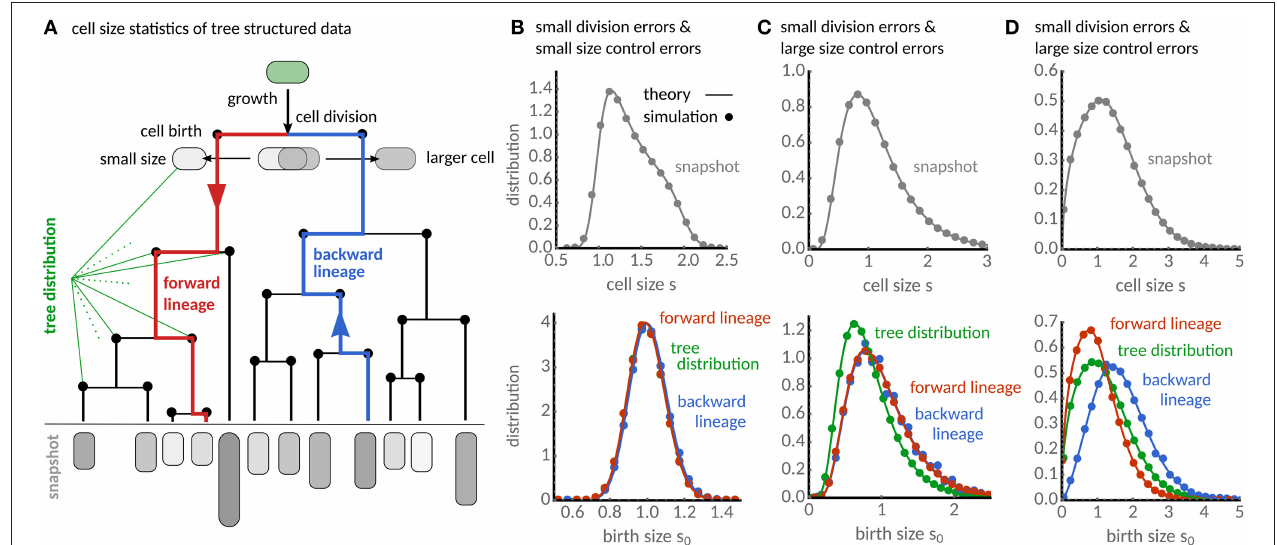
FIGURE 1 | Characterization of cell size statistics from tree-structured data. (A) Lineage tree resulting from cell growth and division. The snapshot distribution characterizes the final state of the tree (gray). The distribution of birth sizes resulting from all cell divisions in the tree (black nodes) is the tree distribution. Forward lineages (red lineage) traverse the tree from root to leaf and follow randomly each daughter cell after division. Backward lineages start a randomly chosen cell in the final population and traverse the tree from leaf to root. (B) The snapshot distribution (gray) for the case of small division errors shows a maximum for newborn cells and decreases progressively toward larger cell sizes. Forward (red), backward lineage (blue) and tree distributions (green) of birth size are qualitatively similar. (C) For large fluctuations in cell size controls (CV η = 0.75) the snapshot distribution broadens significantly (gray). Distributions of forward and backward lineages are almost indistinguishable, while the tree distribution (green) shows that cells are typically smaller compared to the lineage statistics. (D) For large division errors (CV p = 0.5), forward, backward lineage and tree distributions appear all significantly different showing cells in forward lineages are typically smaller than in backward and tree distribution. The analytical results (solid lines) are verified using stochastic simulations in all cases (dots). Theory and simulations use adder rule ( a = 1), gamma-distributed cell cycle noise with E [ η ] = 1 and CV η = 0.1, and division errors following a symmetric beta distribution with CV p = 0.07 unless stated